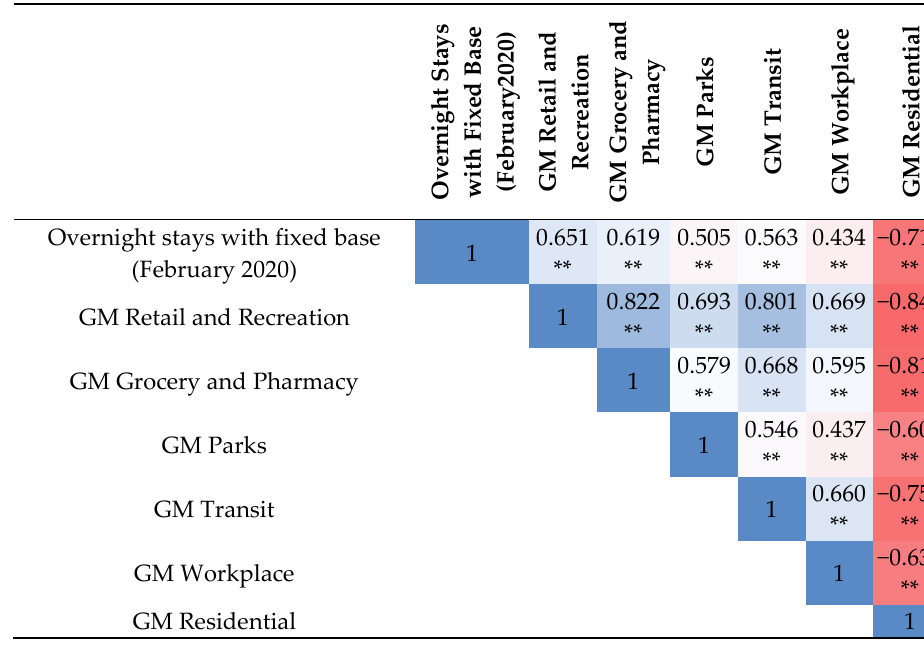
Figure 3. The heat map for correlations of Google Mobility indices. for p < (Note: ** statistically significant for p< 0.001)